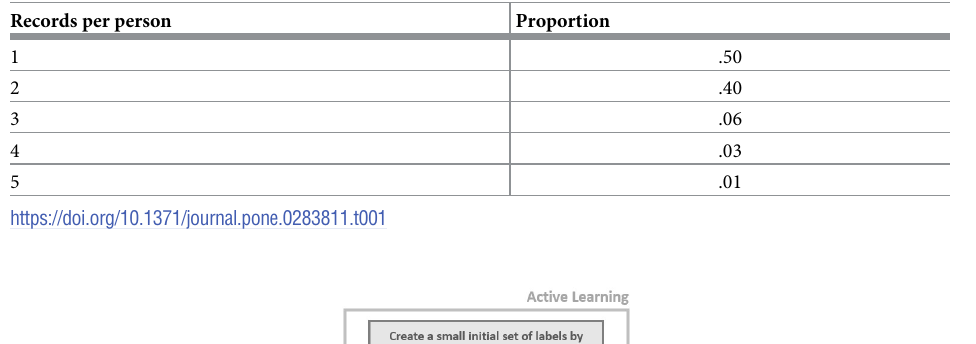
Table 1. Distribution of records per individual in training and evaluation data.